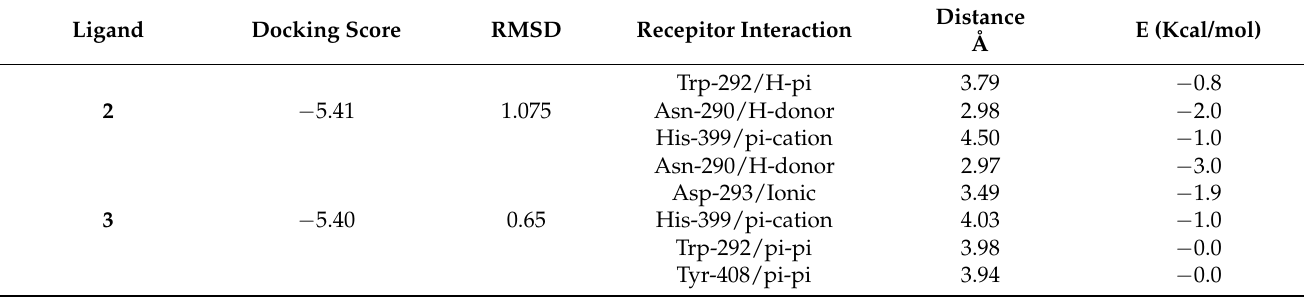
Table 5. The binding scores, RMSD values, receptor interactions, distances, and energies of our promising candidates ( 2 , 3 , 5 , and 6 ) were recorded compared to the docked ascorbic acid as